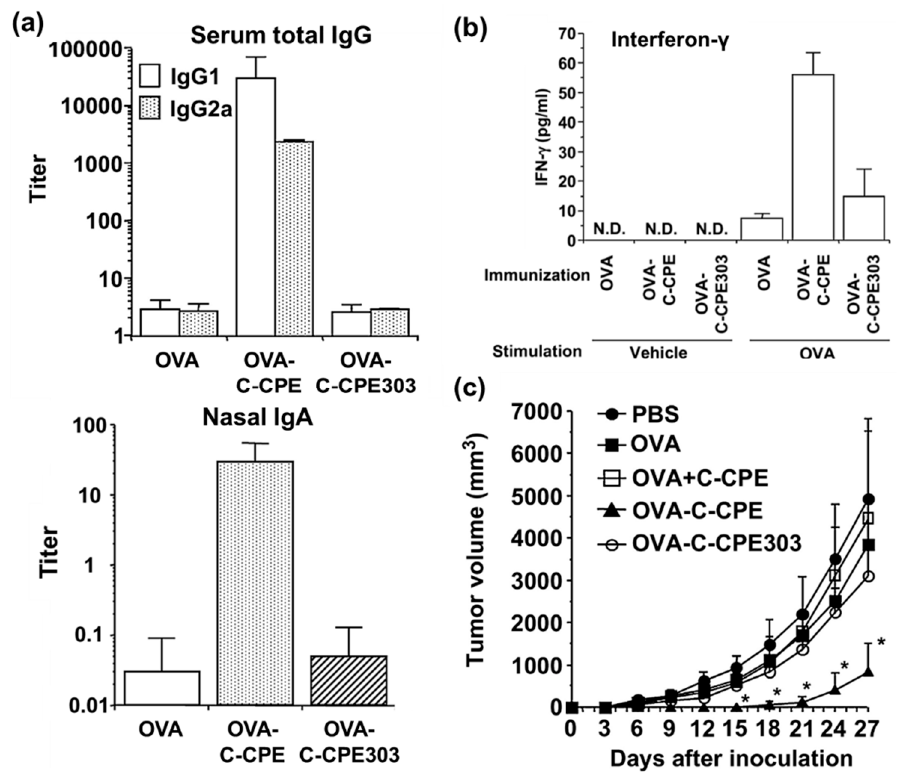
Figure 5. The e ff ect of claudin-4-targeted mucosal immunization on systemic and mucosal immunity. (a and b) Mice were nasally immunized with ovalbumin (OVA), OVA-C-CPE, or OVA-C-CPE303 (which lacks the minimal claudin-binding region) (5 µ g OVA in each formulation) once a week for 3 weeks. Seven days after the last immunization, serum and splenocytes were harvested. ( a ) The levels of serum IgG1 and IgG2a (upper panel) and nasal IgA (lower panel) were measured. ( b ) The splenocytes were stimulated with vehicle or OVA (1 mg / mL) for 24 h, and interferon- γ in the supernatant was measured. ( c ) Mice were nasally immunized with vehicle, OVA, a mixture of OVA and C-CPE, OVA-C-CPE, or OVA-C-CPE303 (5 µ g OVA in each vaccine) once a week for 3 weeks. Seven days after the final immunization, the mice were injected subcutaneously with 1 × 10 6 OVA-expressing EL4 (H-2b) cells. The tumor volumes were measured over time. The data are shown as the mean ± S.D. ( n = 4). * p < 0.05. The data are reproduced from reference [97] with slight modifications and permission from the copyright holder.